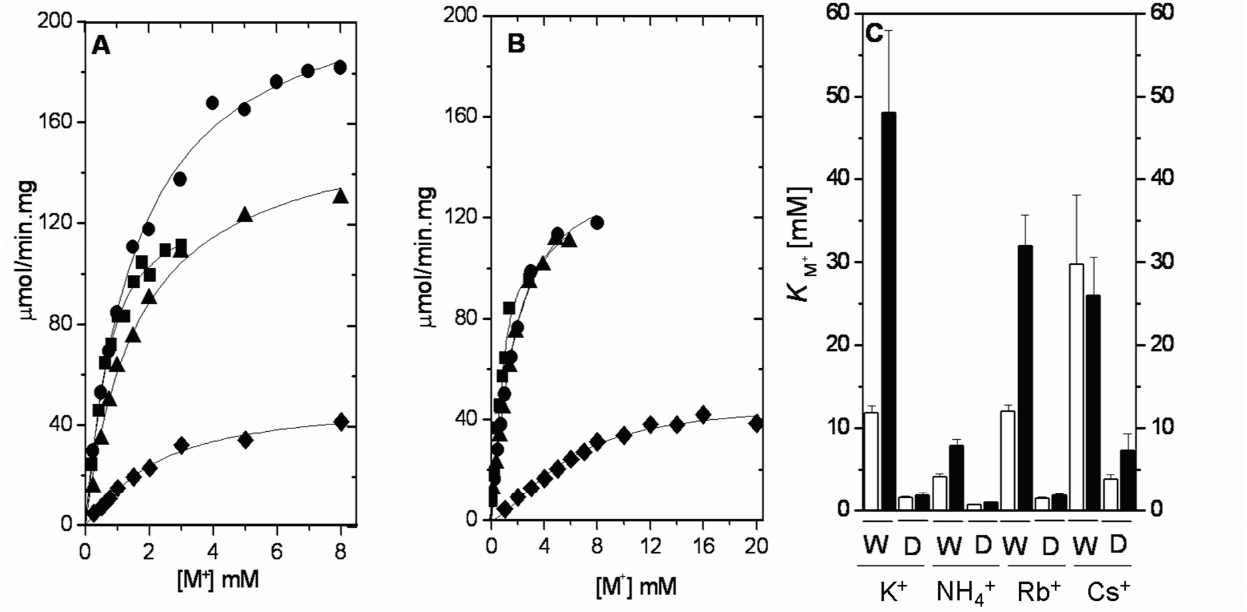
Figure 3. Activation of WT-RMPK ( A ) and T113L-RMPK ( B ) by K + ( ● ), NH 4+ ( ■ ), Rb + ( ▲ ) or Cs + ( ♦ ) at saturating PEP 3 − and ADP-Mg complex in 20% DMSO; ( C ) K of monovalent cations indicated for WT-RMPK (white bars) compared to those of T113L-RMPK (black bars) in 100% water (W) and 20% DMSO (D). The activities in the presence of the indicated concentrations of monovalent cations were measured. The mean of two experiments is shown in ( A ) and ( B ). In plot ( C ), the constants and standard deviations were taken from Tables S3 and S6, where K represents K m or K 0.5